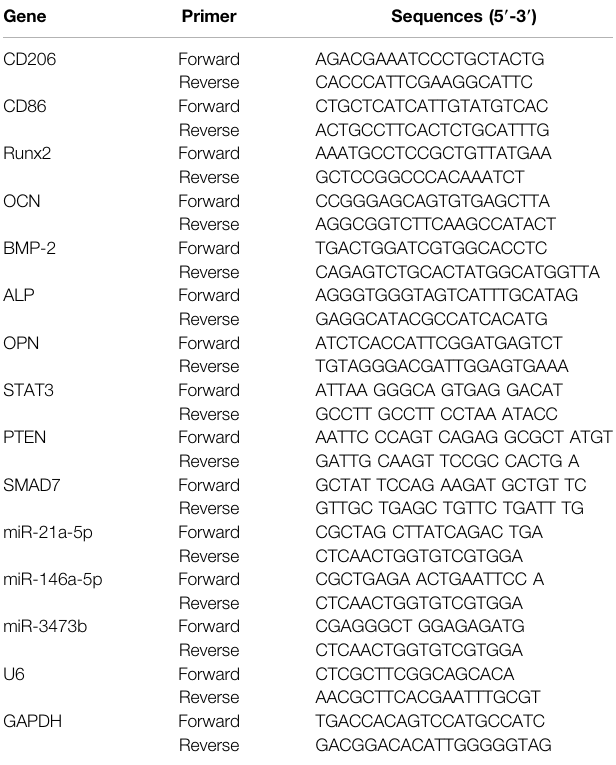
TABLE 1 | Primer sequences used in this